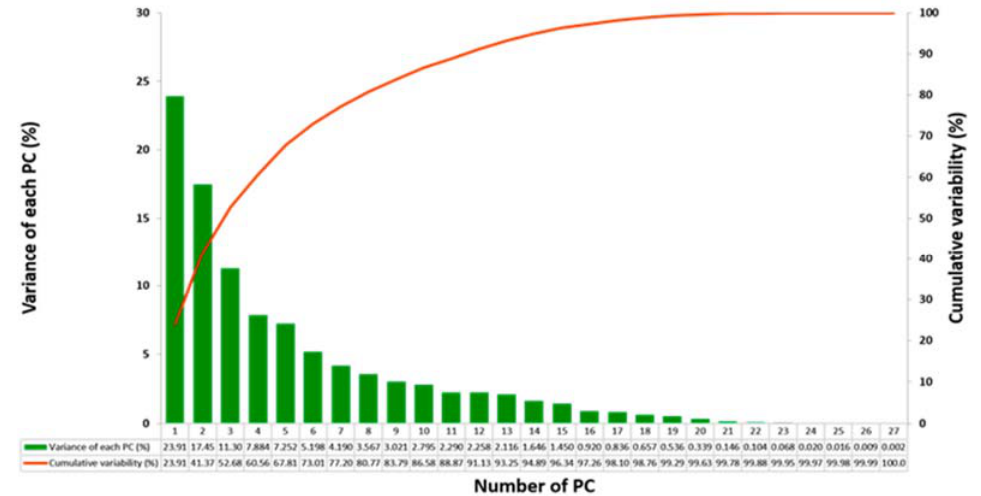
Figure 4. Number of components selected from the principal component analysis (PCA) for training the classifiers.